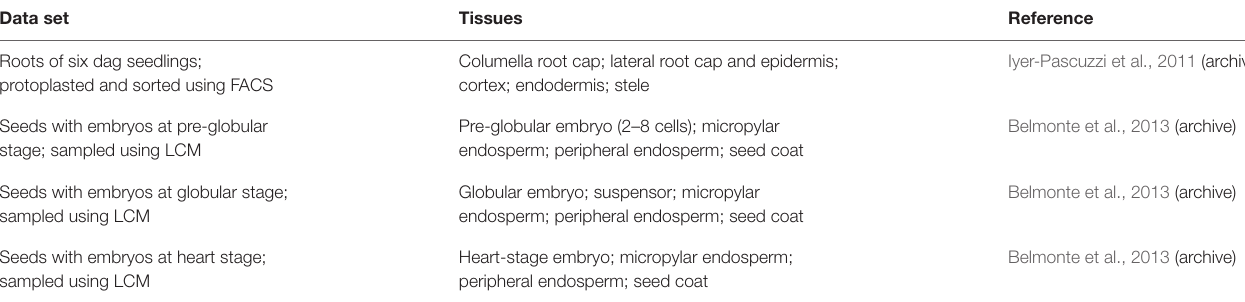
TABLE 1 | Data sets used in this